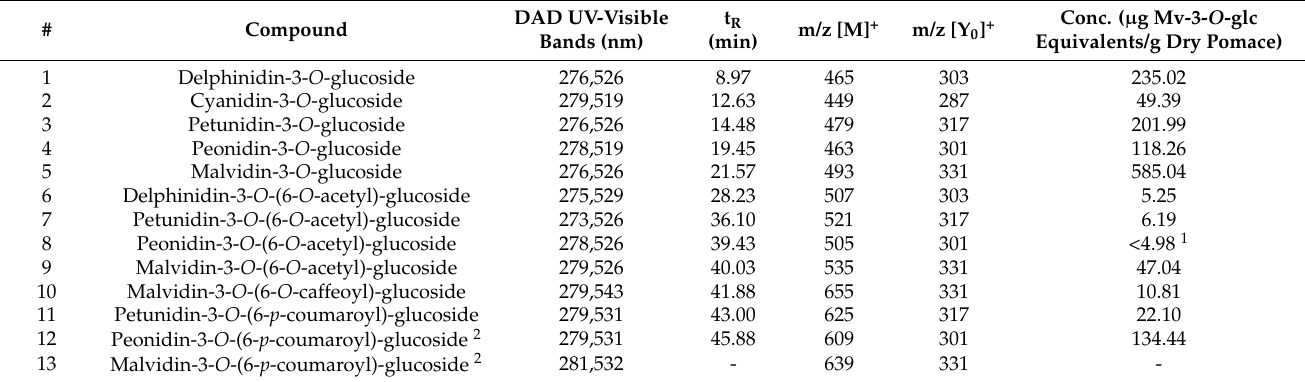
Table 2. Determination of anthocyanins in Tempranillo grape pomace extract determined by using HPLC-DAD-ESI-QqQ/MS